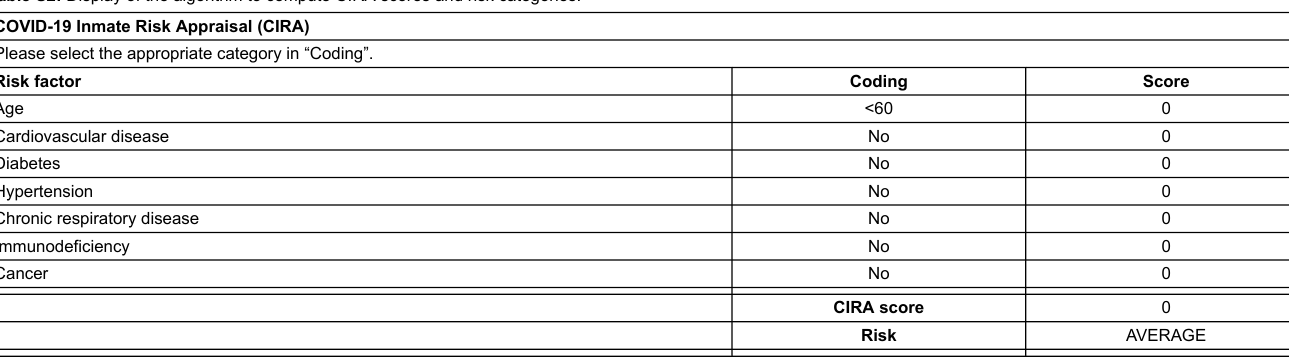
Table S2: Display of the algorithm to compute CIRA scores and risk categories. COVID-19 Inmate Risk Appraisal (CIRA) Please select the appropriate category in